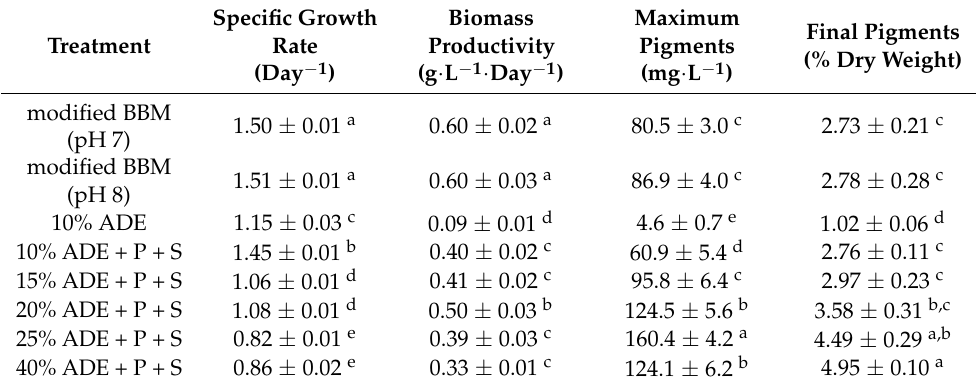
Table 2. C. sorokiniana culturing characteristics when grown under different